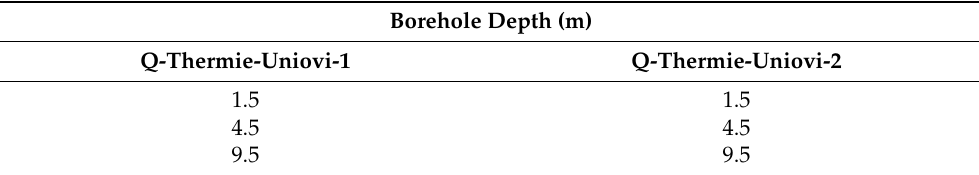
Table 1. TMCx-HD sensor locations for the two boreholes.